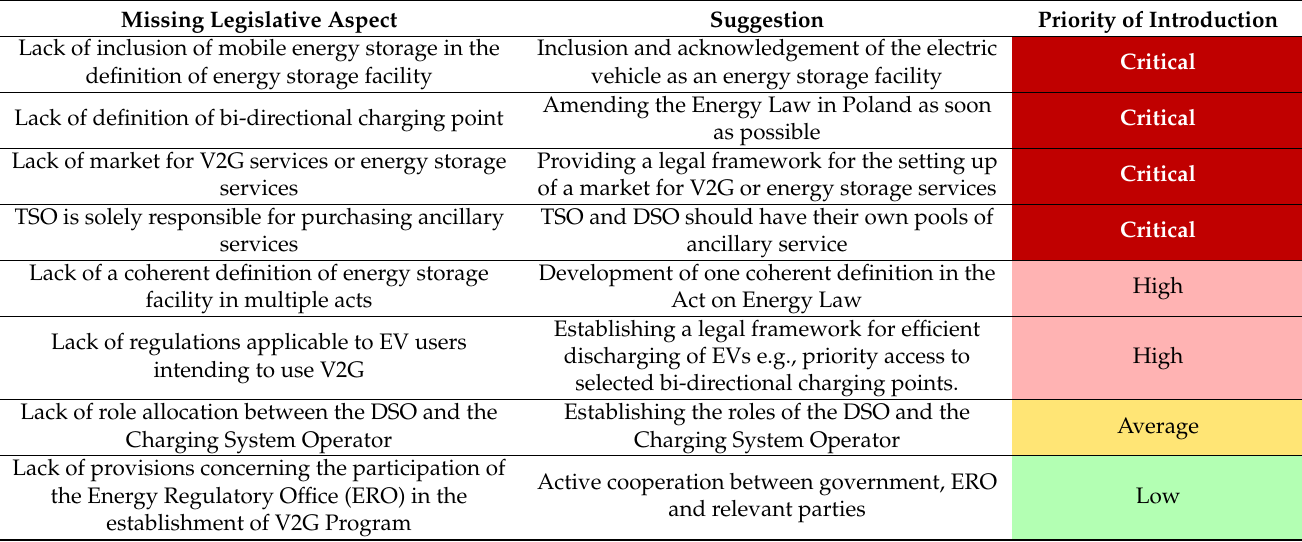
Table 2. Possible changes in Polish Law for smooth implementation of V2G